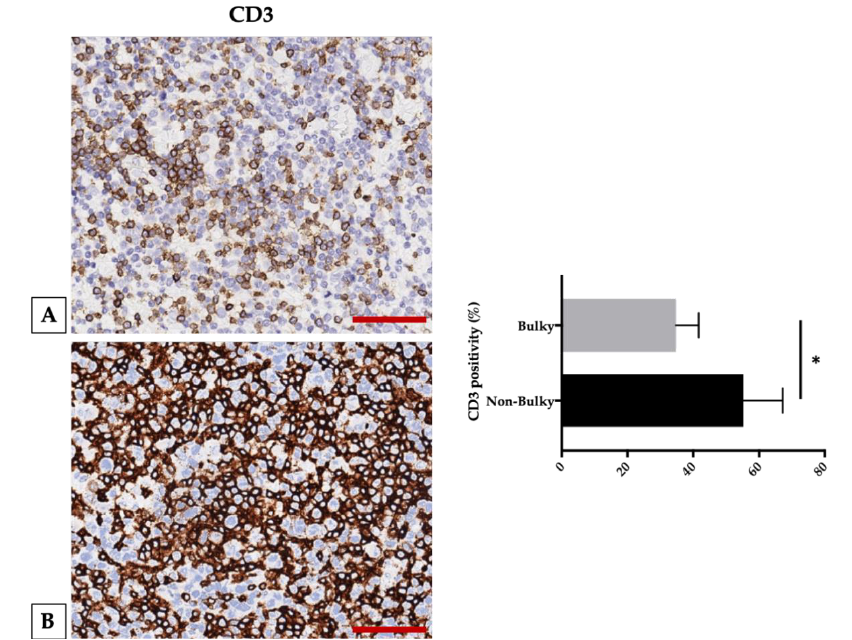
Figure 2. CD3 expression in bulky and non-bulky DLBCL. Left panel: ( A ) Representative image of CD3 expression in a case with bulky involvement. ( B ) Representative image of CD3 expression in a case with non-bulky DLBCL. Right panel: comparison between bulky and non-bulky disease groups with a significant difference between the groups in the CD3 infiltrate . Scale bar: 50 μm. * p < 0.05, assessed by Mann – Whitney test. Representative images from 29 untreated DLBCL patients are presented [113].